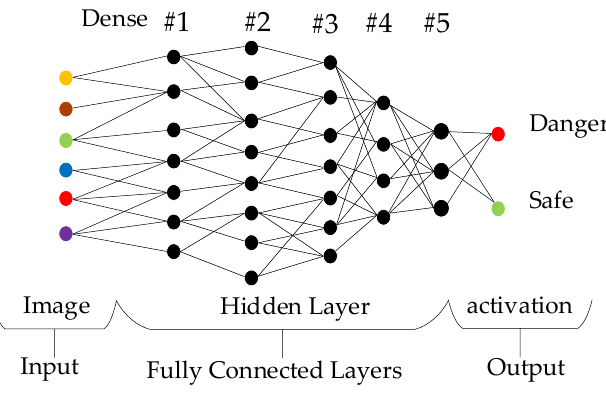
Figure 2. Schematic diagram of fully connected layer neuron cross iteration.